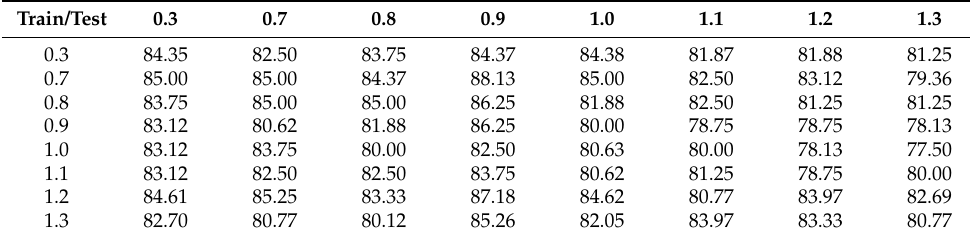
Table 4. Accuracy obtained by FN 128 with different resizing factors (reported in percentage).